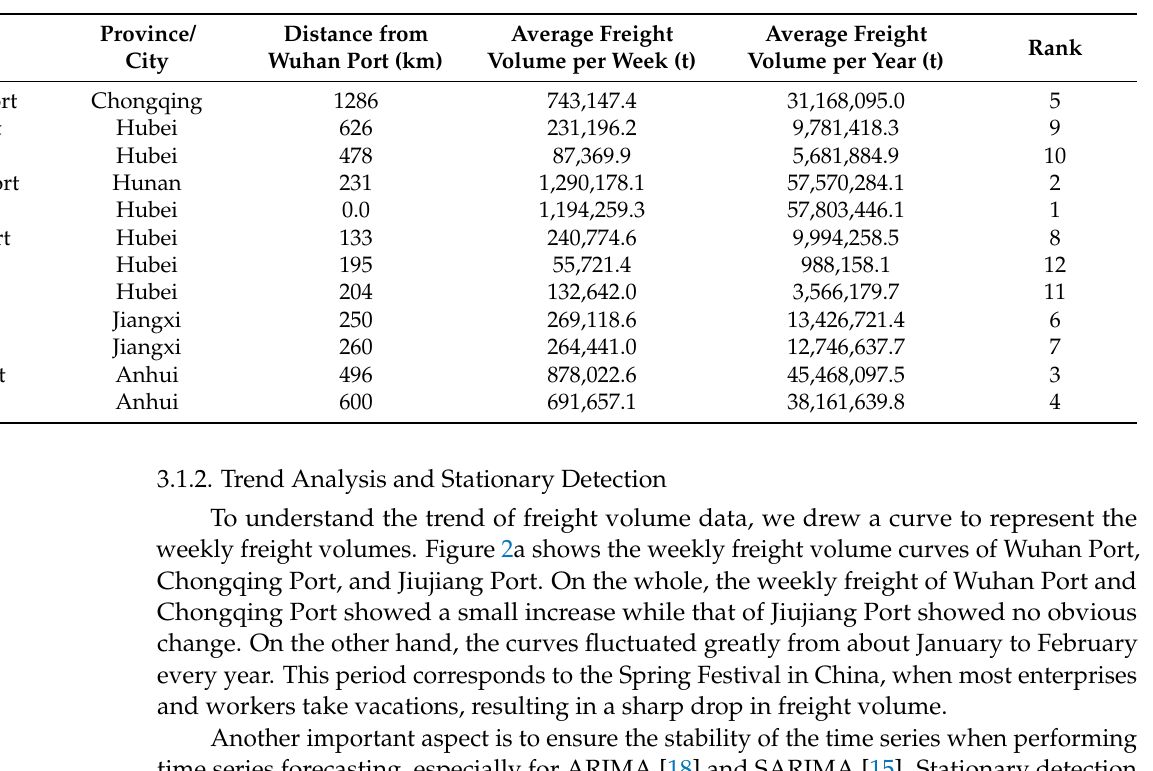
Figure 1. The geographic location of the studied ports. Table 1. Port information and freight volume